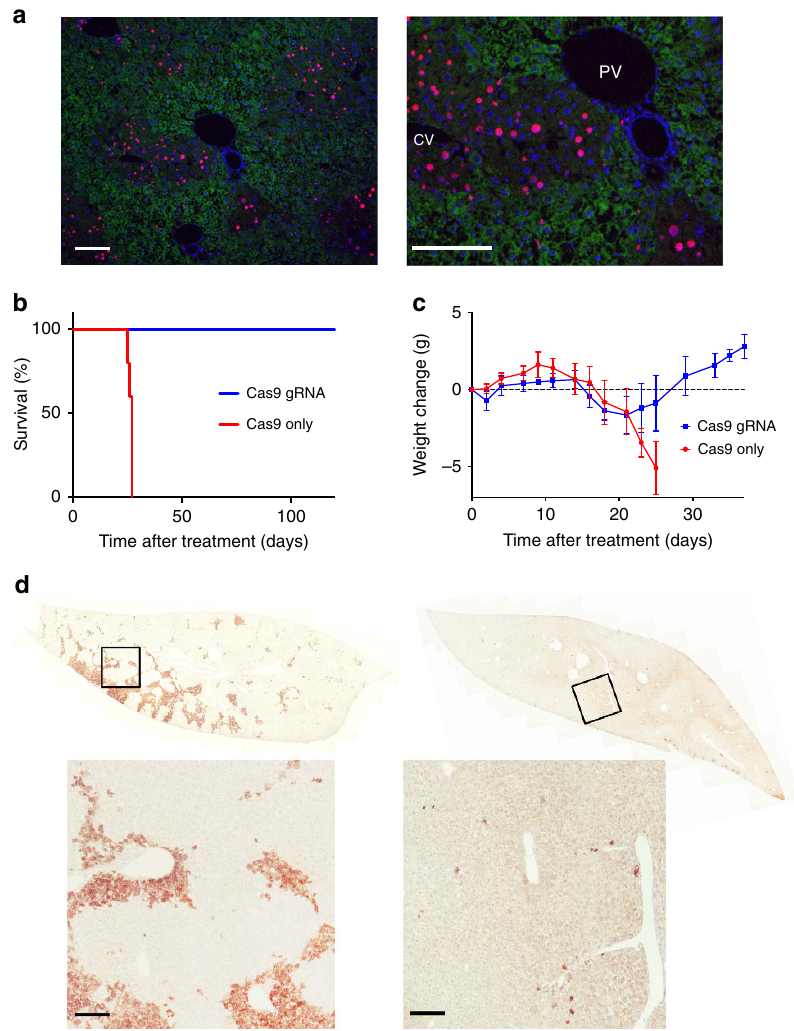
Figure 2 | Proliferation of reprogrammed hepatocytes ( Fah (cid:2) / (cid:2) / Hpd (cid:2) / (cid:2) ) rescues HT-I lethality. ( a ) Co-staining for EdU (red) and HPD (green), counterstain is 4,6-diamidino-2-phenylindole (blue). Proliferating, EdU-positive cells are HPD-negative. Kaplan–Meier survival curves ( b ) and body weights ( c , mean ± s.d.) of tyrosinemic animals treated with either Cas9 only or both Cas9 and gRNA1/3 (each group N ¼ 5). Time after withdrawal from nitisinone (7 days after injection) is shown. ( d ) Range of repopulation by reprogrammed hepatocytes ( Fah (cid:2) / (cid:2) / Hpd (cid:2) / (cid:2) ) 8 weeks after injection. The mouse on the right has an almost complete repopulation by edited hepatocytes ( 4 99%) and only a few non-edited ( Fah (cid:2) / (cid:2) /Hpd þ / þ ) hepatocytes are visible in the whole section. Black squares are amplified in the images below. Scale bar, 50 m